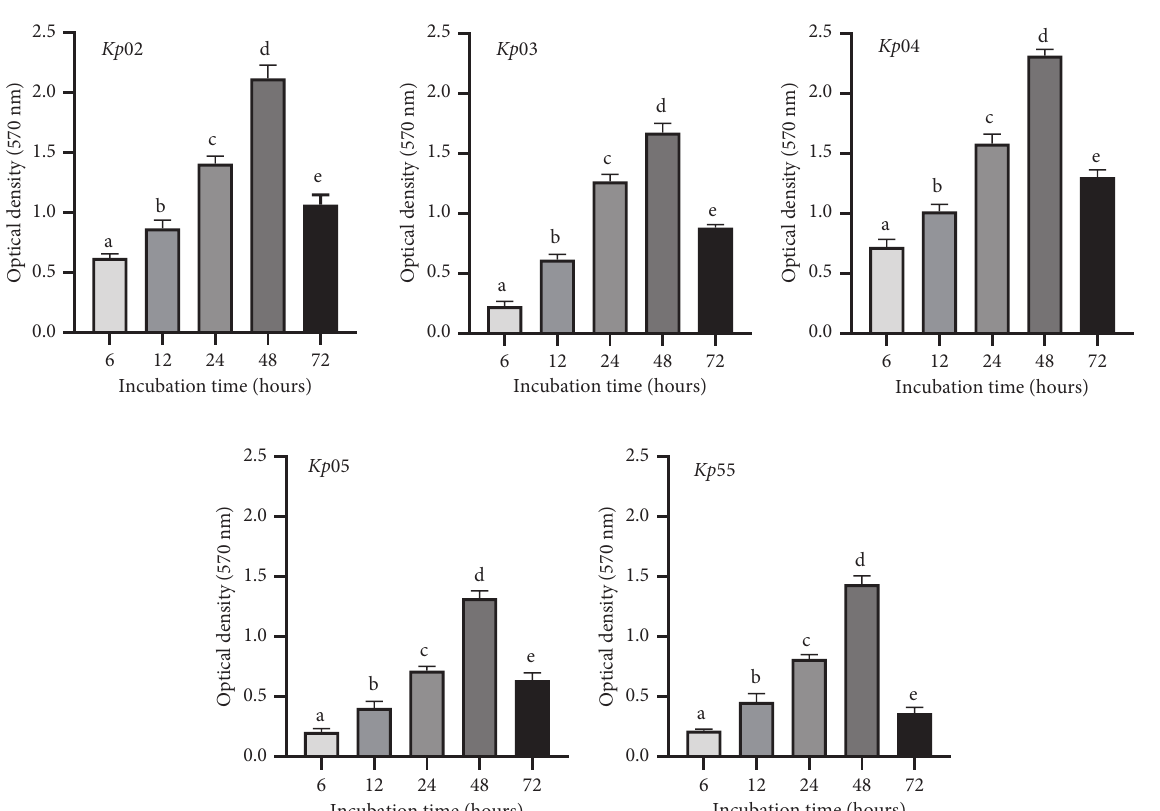
Figure 1: Kinetics of the biofilm-producing capacity of K. pneumoniae clinical isolates. Clinical isolates of K . pneumoniae were incubated for 72h, and the biofilm was analyzed at 6, 12, 24, 48, and 72h to determine the best time for maximum biofilm formation. The bar graphs represent the mean ( n � 3) ± standard deviation (error bars) of the values corresponding to each time of incubation for biofilm formation. Different letters (a, b, c d, and e) above bars indicate a significant difference between the values ( p < 0 . 05 according to Fisher’s least significant